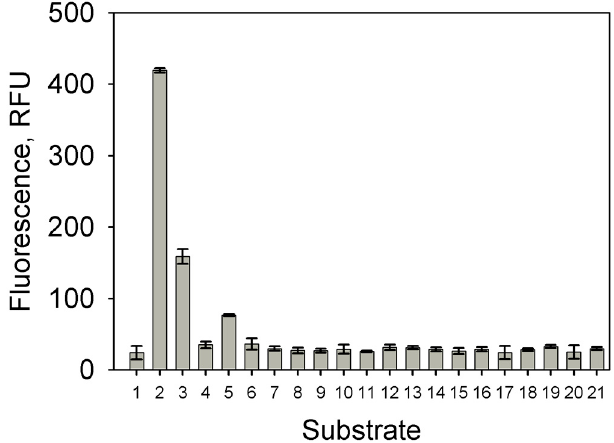
Figure 7. Substrate specificity of TpdR. 1—fluorescence of bacteria grown without inductor, 2—with tetramethylpyrazine, 3—2,3,5-trimethylpyrazine, 4—2,3-dimetylpyrazine, 5—2,5-dimetylpyrazine, 6—2,6-dimetylpyrazine, 7—2,3-diethyl-5-methylpyrazine, 8—3-methylpyridazine, 9—pyrazine, 10—